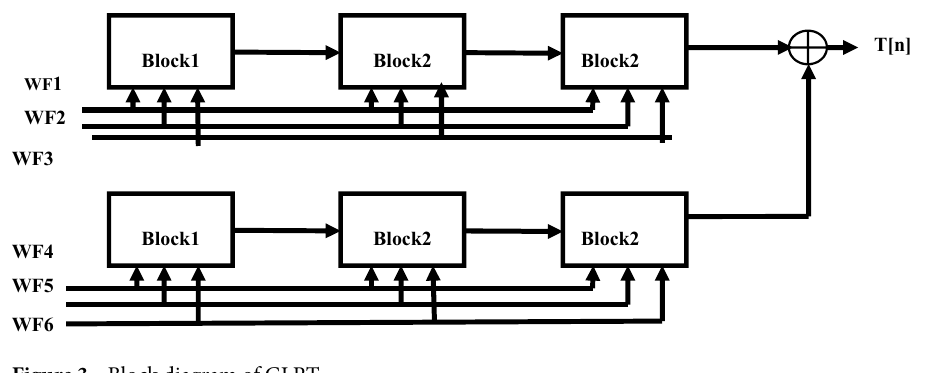
Figure 3. Block diagram of